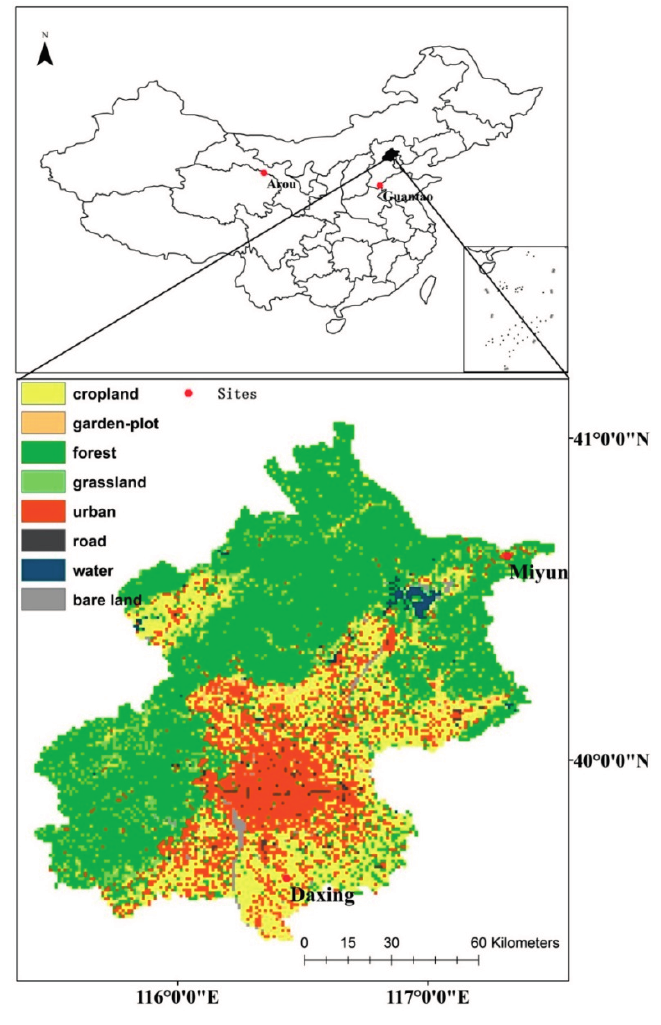
Figure 2. Site locations and land use of Beijing in China,